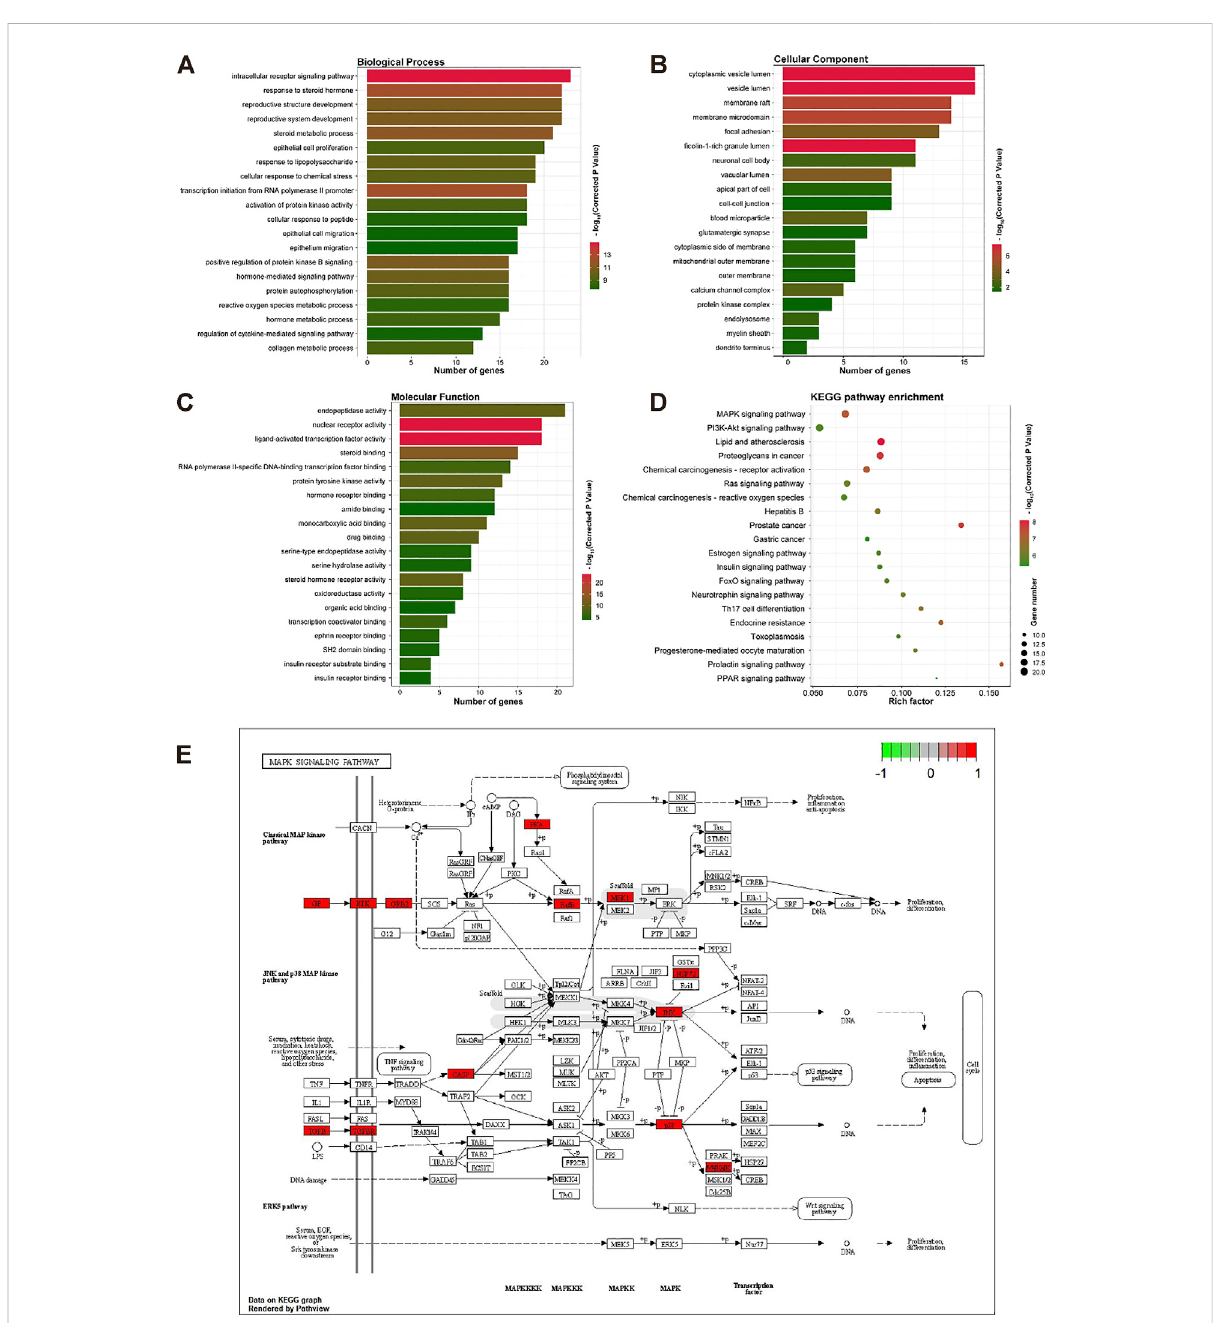
FIGURE 4 The GO and KEGGenrichmentanalysisofthecommontargets of OMT, in fl ammation, and itch. (A – C) GO enrichment analysis of thebiological process, molecular function, and all components; X -axis for gene number and p -value for color. (D) KEGO enrichment analysis of the Common targets of OMT, in fl ammation, and itch. Y -axis for pathway, X -axis for gene number and p -value for color. (E) MAPK signaling pathway in the anti- in fl ammatoryandantipruriticeffectofOMT.PathwayanalysisofthecommontargetsofOMT,in fl ammation,anditch.Thefunctionalanalysisof genes was enriched in the KEGG signaling pathway. The MAPK signaling pathways in the anti-in fl ammatory and antipruritic effect of OMT were highlighted in